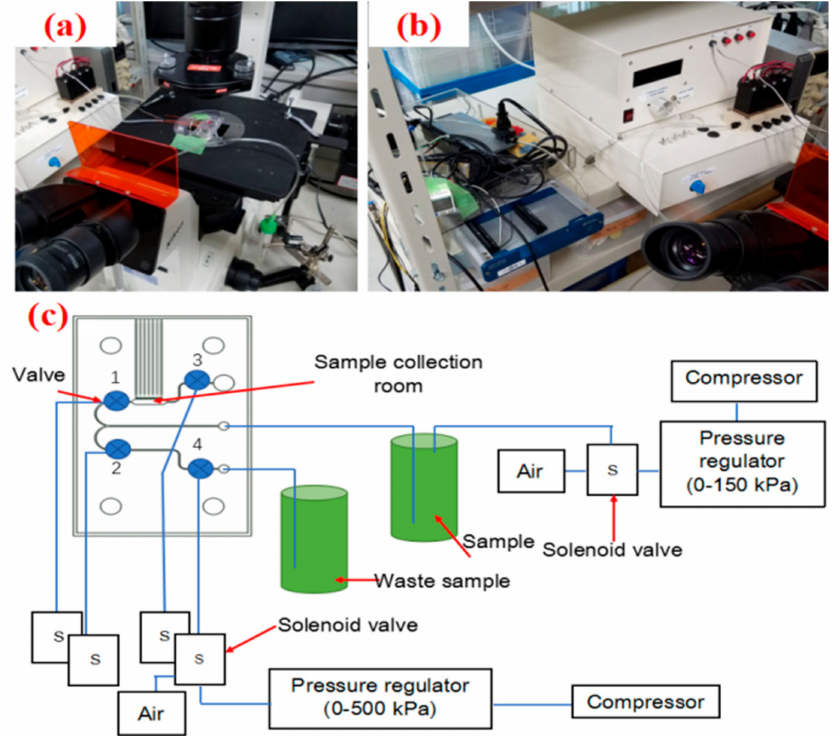
Figure 3. Experimental setup for demonstration of PDMS membrane that actuated cell-capturing device. ( a ) Actual setup of the device. ( b ) Fluidic connection and control of the device. ( c ) The principle of control and connection system of the cell-capturing